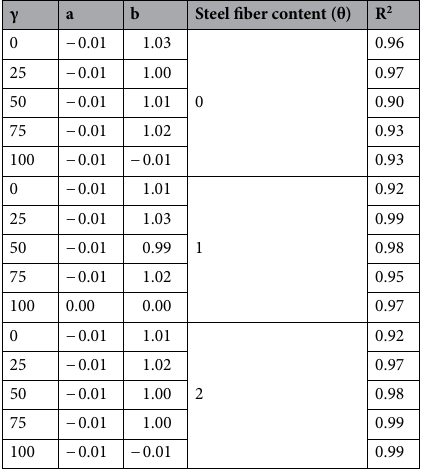
Table 5. Results of γ-value parameter analysis (relative dynamic elastic modulus fitting).